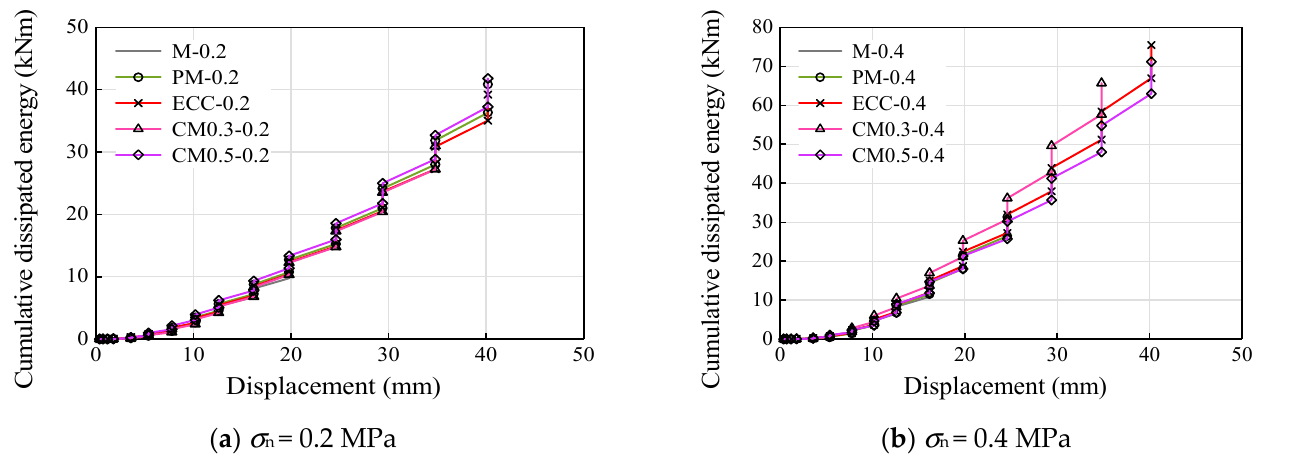
Figure 17. Cumulative energy dissipation: ( a ) σ n = 0.2 MPa and ( b ) σ n = 0.4 MPa. Table 4. Total dissipated energy of the test